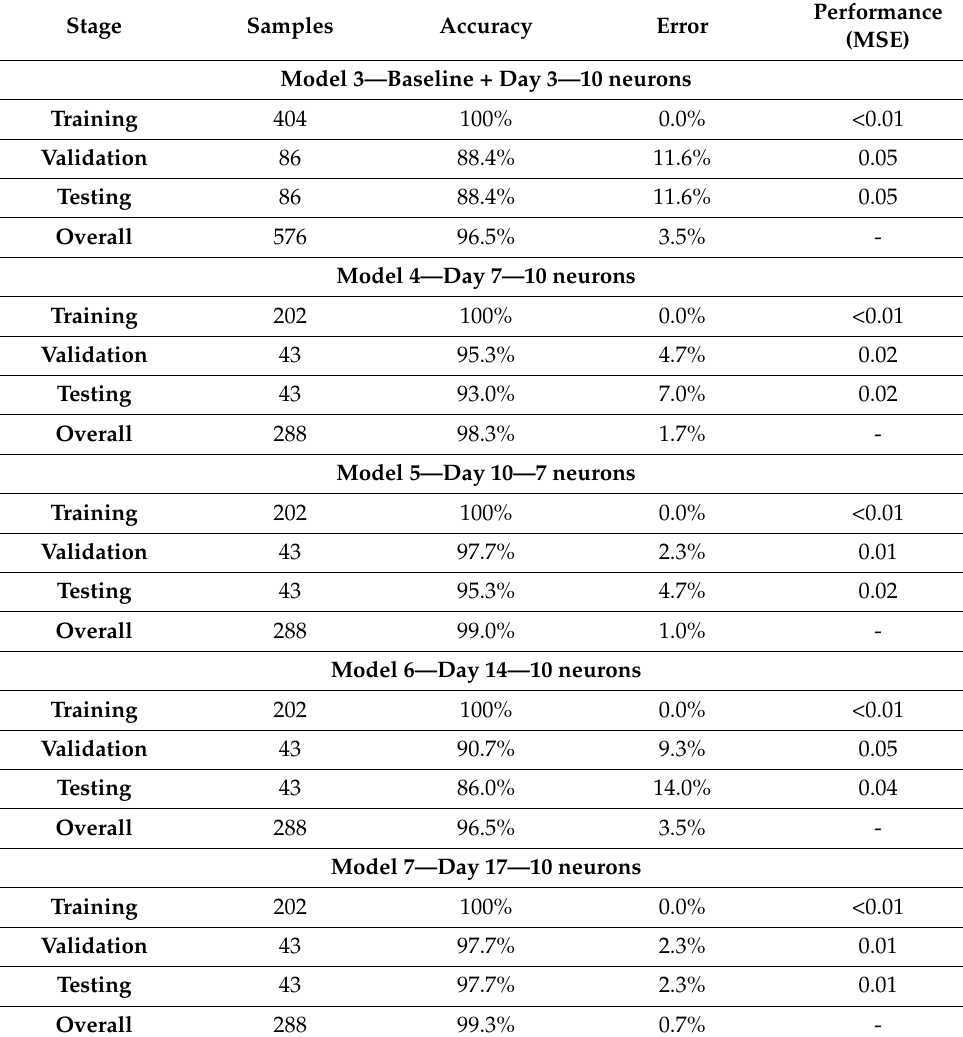
Table 3. Machine learning pattern recognition models based on artificial neural networks (Levenberg– Marquardt) to classify samples into infestation treatment levels using the near-infrared absorbance values as inputs. Abbreviations: MSE: means squared